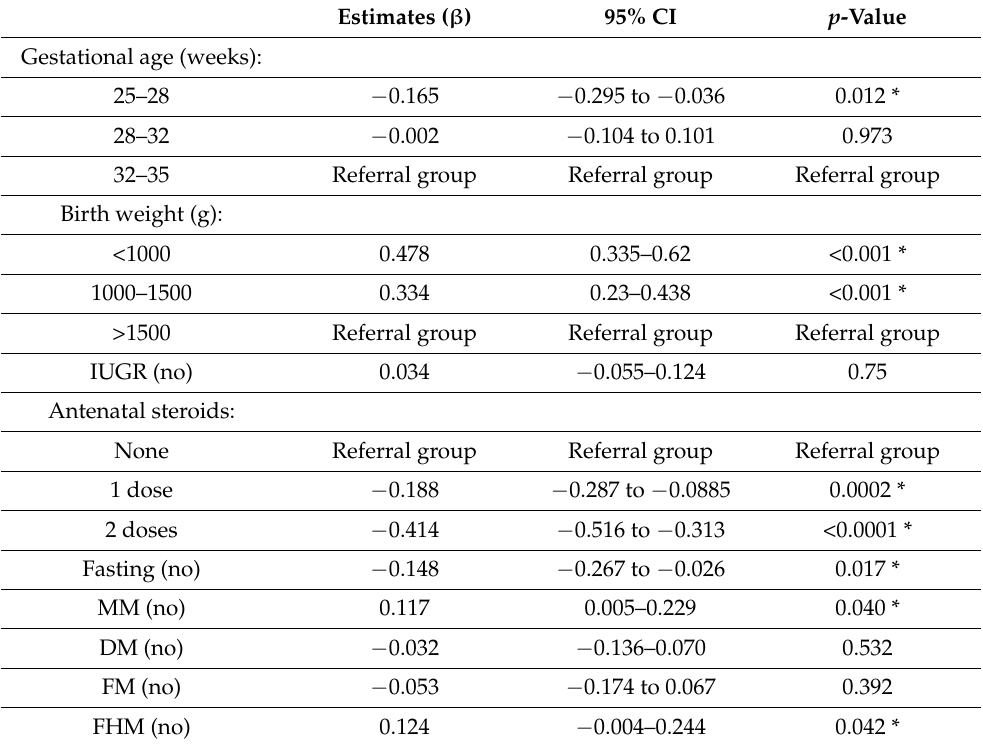
Table A3. Relationship between feeding strategies and NEC across three time-points (3, 7 and 14 days): results from Mixed Model.